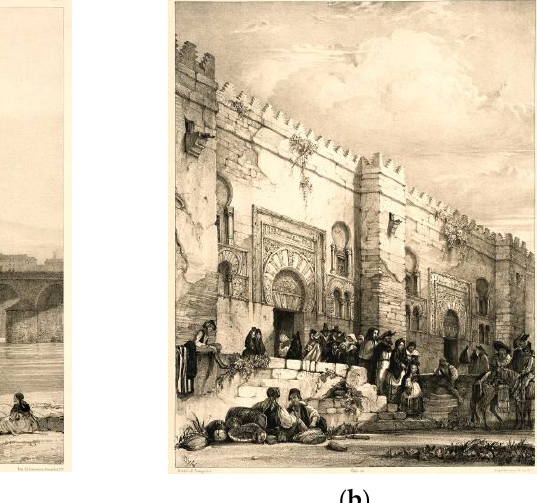
Figure 7. Girault de Prangey: ( a ) Front view from the forest of columns and mihrab (Villemin, lit.); ( b ) Mihrab side view (Wyld, lit.). Source: Monuments arabes et moresques de Cordoue, 1839.